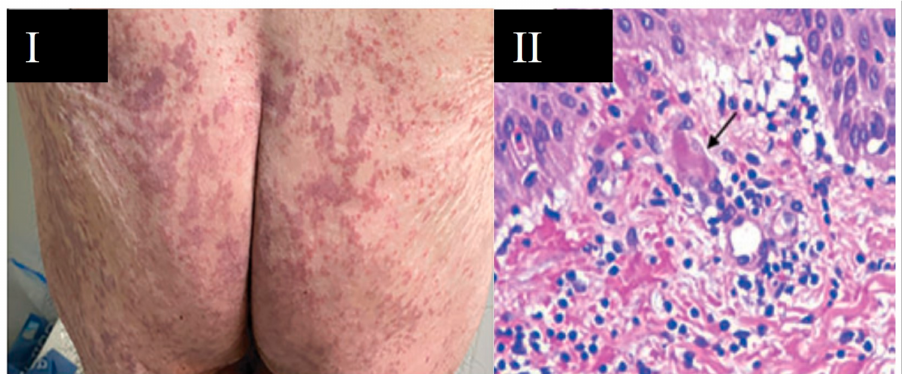
Figure 6. Vascular damage by COVID-19. ( I ) Livedoid lesions or necrosis pattern as a consequence of a vasculopathy; ( II ) skin biopsy with focal thrombosis (arrow) in the papillary dermis capillaries and extravasation of hematomas (HE × 100). Singh H. et al. (2021) [22].